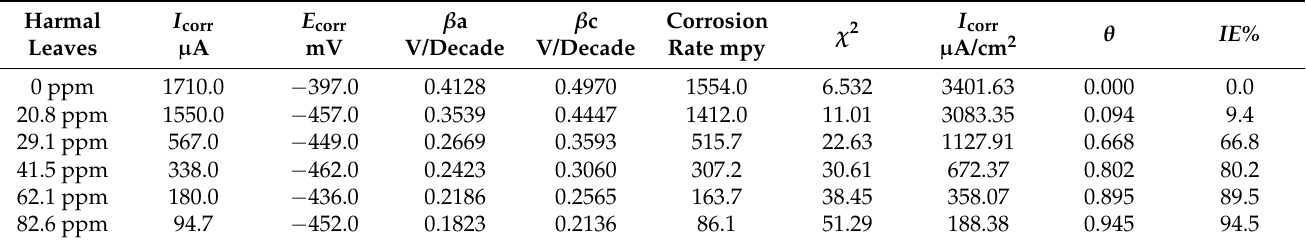
Table 9. Polarization parameters for various concentrations of Harmal leaf extract on the C-steel in